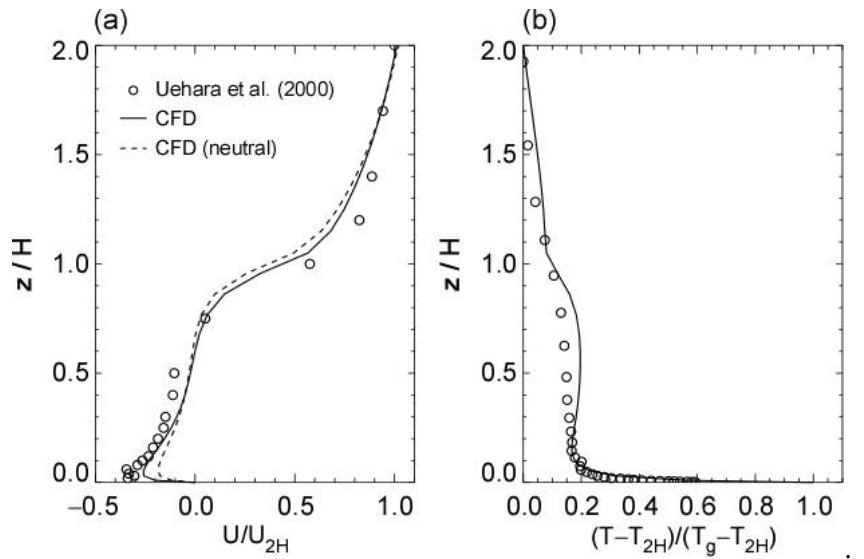
Figure 3. Comparison of the simulated and measured ( a ) wind and ( b ) temperature profiles at the center of a street canyon.